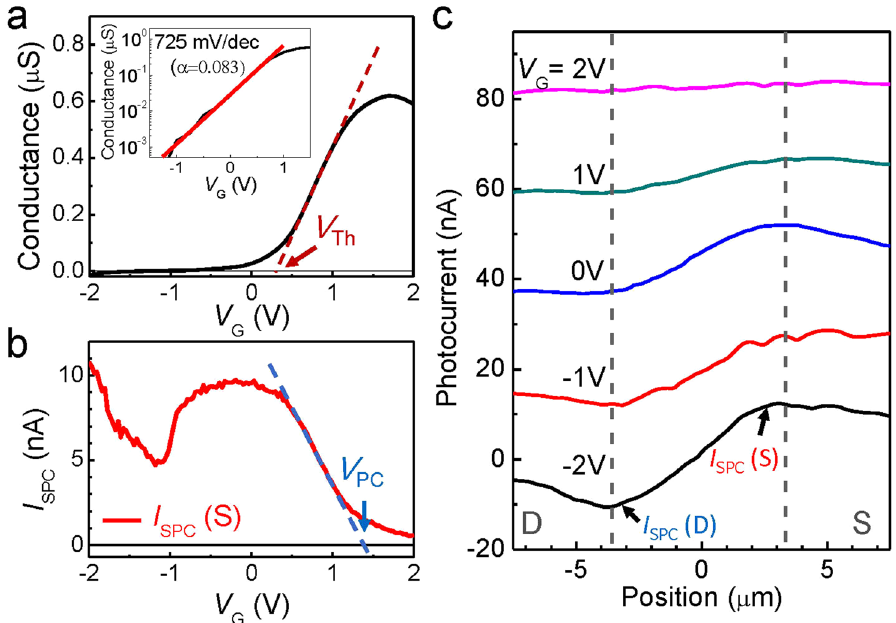
Figure 4. ( a ) Conductance of a 2DEG device as a function of V G . V Th denotes the threshold voltage where the conductance is turned on. (inset) Logarithmic plot of conductance vs V G (black line). Red line is a fit to the data. ( b ) I SPC as a function V G near source electrode. V PC denotes the voltage where the photocurrent ( I SPC ) is turn-off. ( c ) Photocurrent profile as a function of position along the device channel for various gate bias. The curves are offset for clarity.